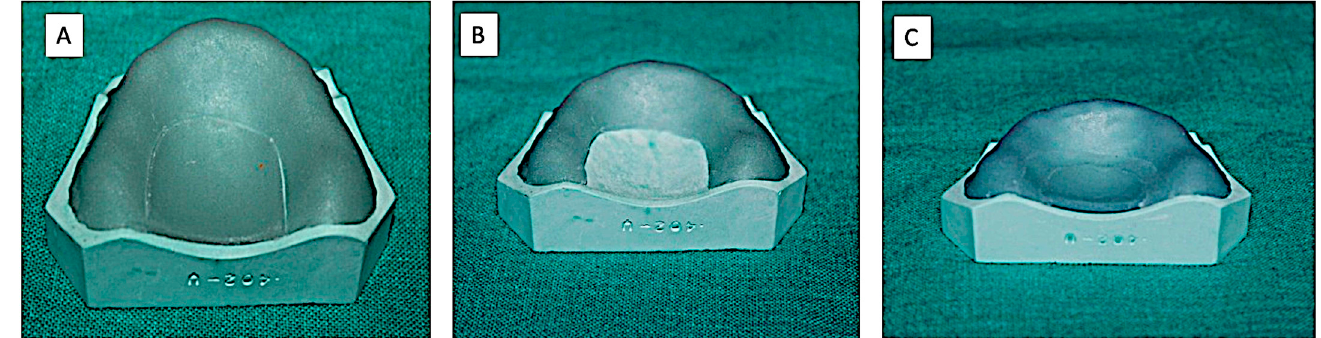
Figure 2. Record Base Fabricated by Conventional Technique (Group-A). Figure 3. Record Base Fabricated by Technique-1 (Group-B). ( A ) The cut along the residual ridge 15 mm below the alveolar crest; ( B ) The remaining VLC sheet on the cast-cured for 4 min; ( C ) The cut U-shape segment replaced on the cast and cured for additional 4 min.